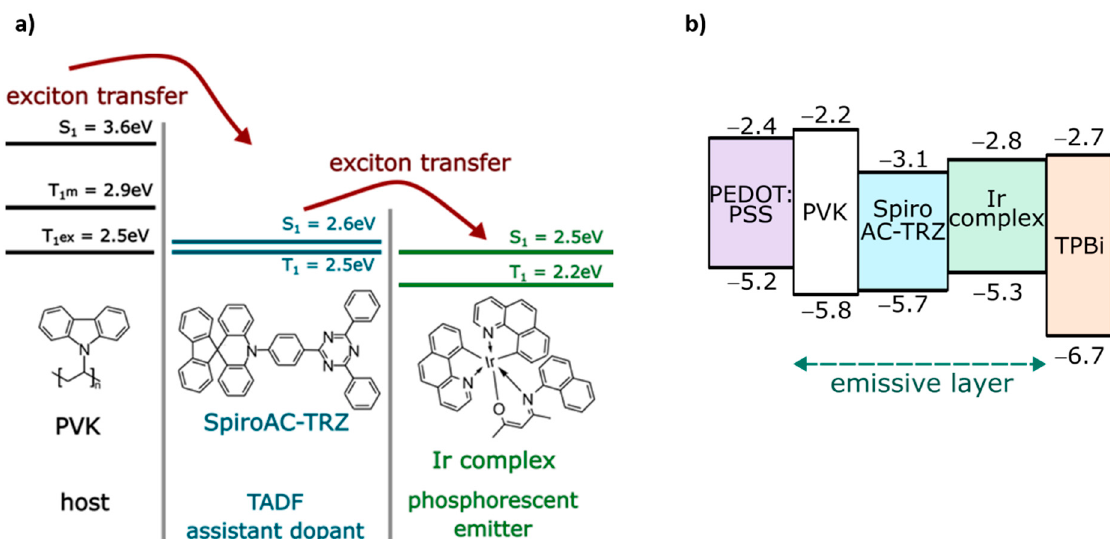
Figure 2. Scheme representing ( a ) singlet and triplet energies of emissive layer components (Tm indicates the triplet of monomer and Tex- triplet of excimer) and ( b ) relations between the highest occupied molecular orbital (HOMO) and the lowest occupied molecular orbital (LUMO) levels of applied poly( N –vinylcarbazole) (PVK) matrix [19] for SpiroAC–TRZ [17] assistant dopant and phosphorescent emitter –Ir complex [16] in organic light emitting diode (OLED) configuration, where poly(3,4–ethylenedioxythiophene) and poly(styrenesulfonate) mixture (PEDOT:PSS) [20] works as hole injection layer (HIL) and 1,3,5-tris(N-phen-ylbenzimidazol-2-yl)-benzene (TPBi) [21] as electron transport layer (ETL).